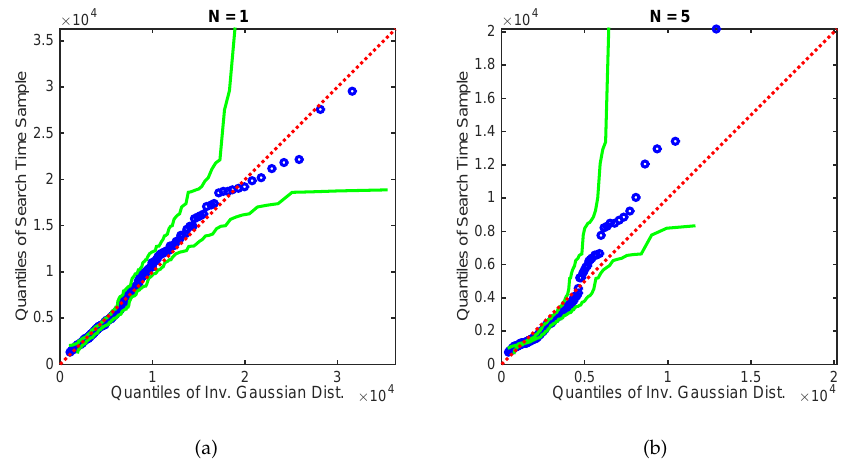
Figure 6. Q-Q plot of the search times for ( a ) N = 1 and ( b ) N = 5, versus the inverse Gaussian distribution with parameters fitted using maximum likelihood estimation. The source location was fixed at [ 187.5,187.5 ] and the initial centroid position at [ 187.5, − 187.5 ] . The green lines show 95% confidence bands